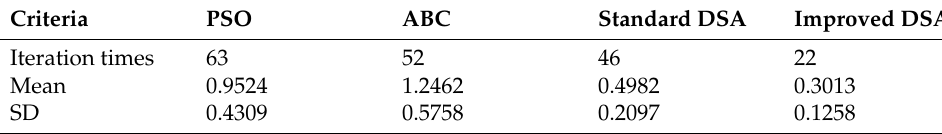
Table 3. Simulation results in case (1): 100 individuals.